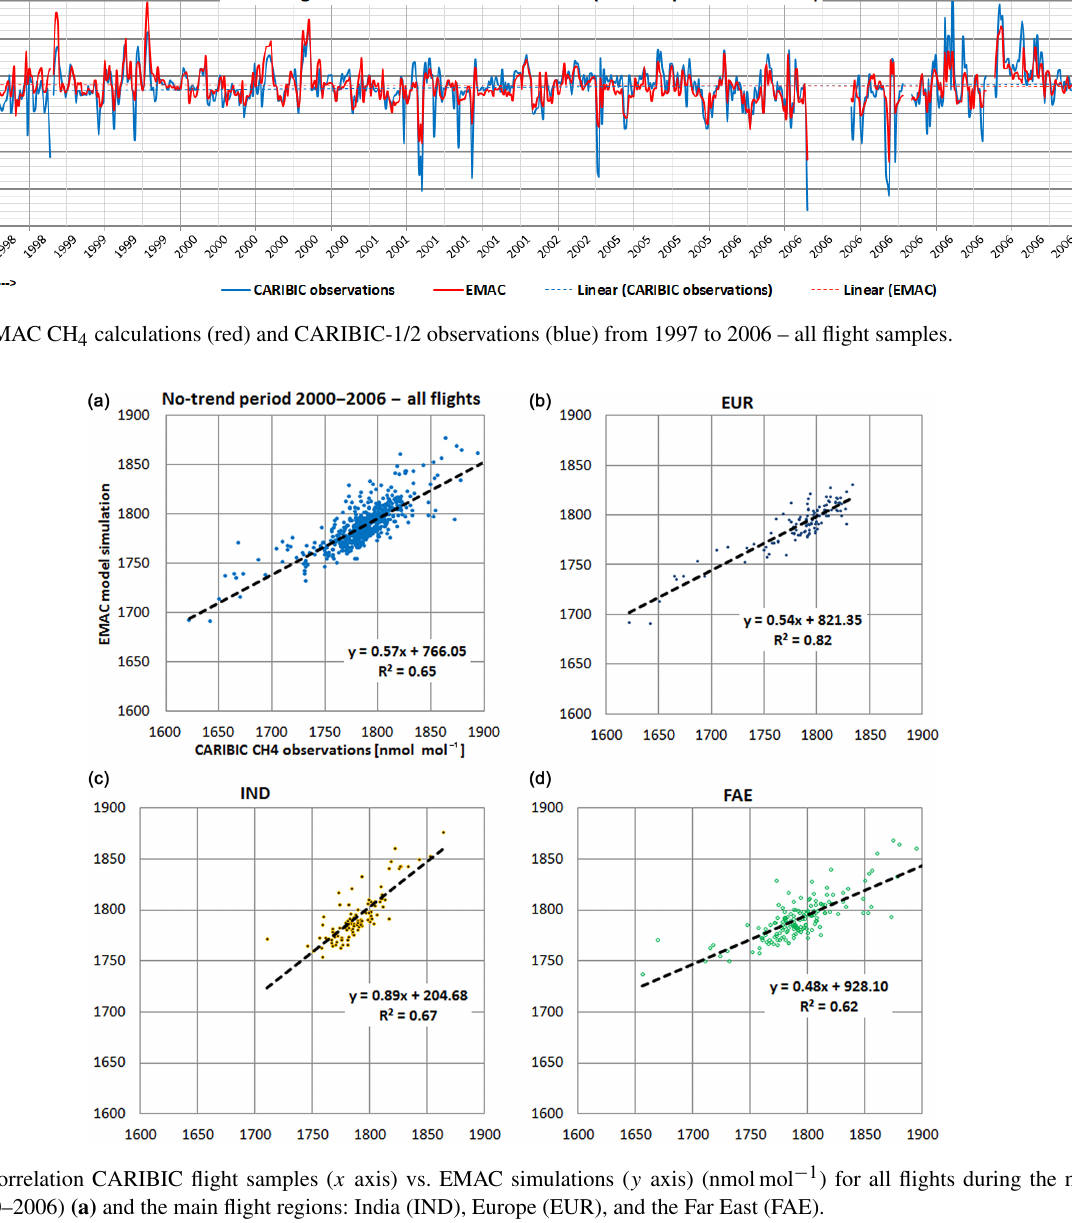
to EUR, a hypothetical FAE contribution cannot be